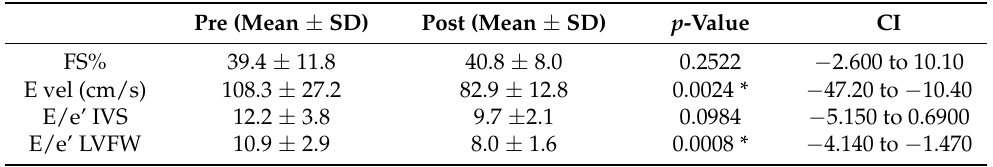
Table 1. Echocardiographic parameters measured at time of diagnose (Pre) and at two months after operations (Post). E vel and E/e’ at LVFW significantly decreased. Standard deviation: SD; 95% confidence interval: CI; fraction shortening: FS; early diastolic left ventricular inflow velocity: E vel; diastolic early mitral ring velocity: e’; significance: * p <